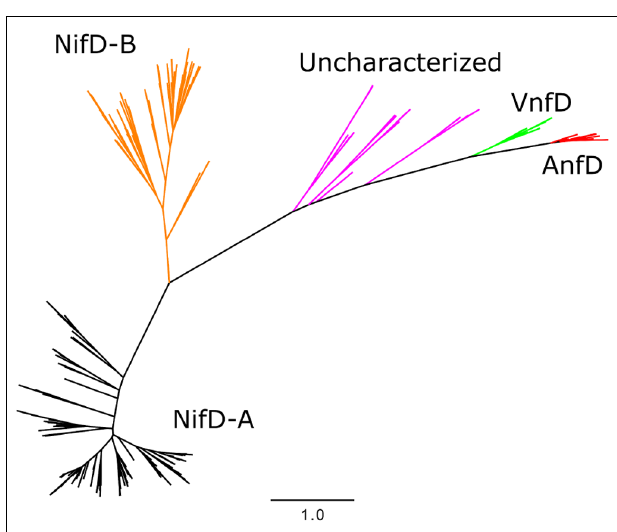
FIGURE 2 | Maximum likelihood unrooted phylogram of nitrogenase sequences. FeMo-co NifD-A and NifD-B sequences in black and orange, respectively, uncharacterized nitrogenases in purple, AnfD in red, andVnfD in